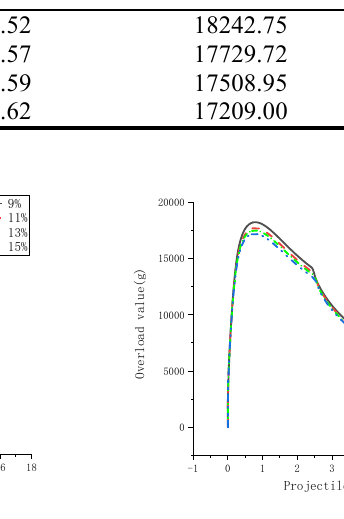
Fig. 7. a-l curves of different mass ratios of the coating